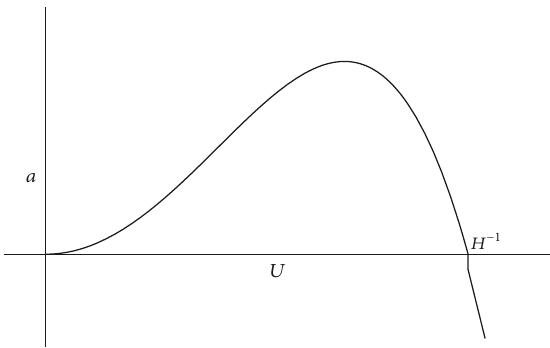
Figure 9: Potential 𝑈(𝑎) for WD equation. Notice the step at 𝑎 = 𝐻 −1